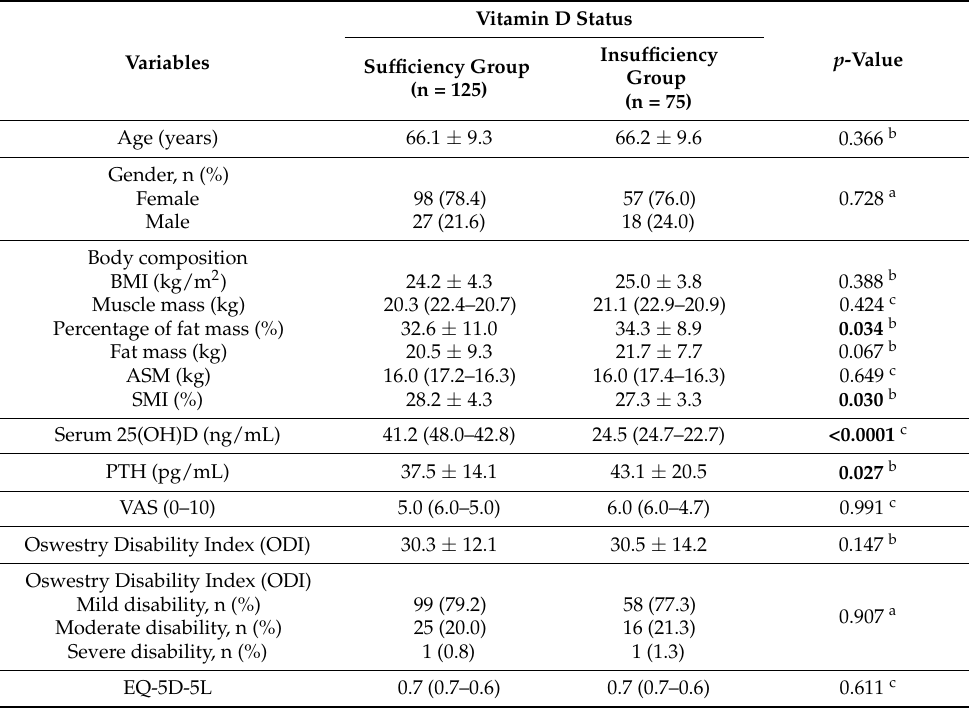
Table 1. Demographic data of LDD patients with vitamin D sufficiency and insufficiency.